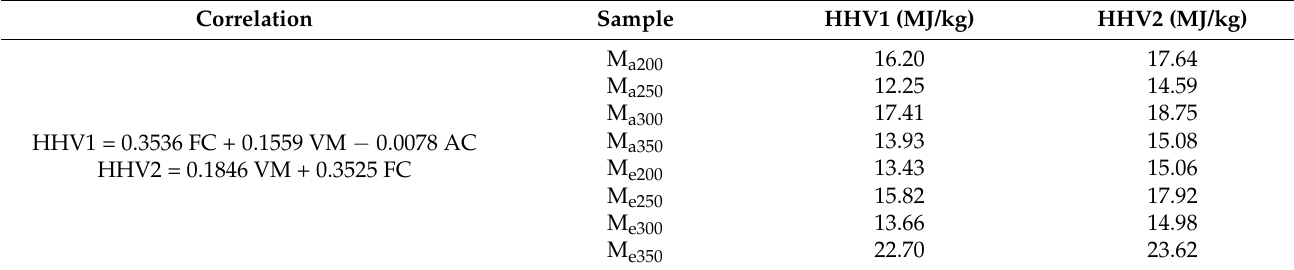
Table 2. Highest energy value (HHV) of the torrefied blend of SS and BG.